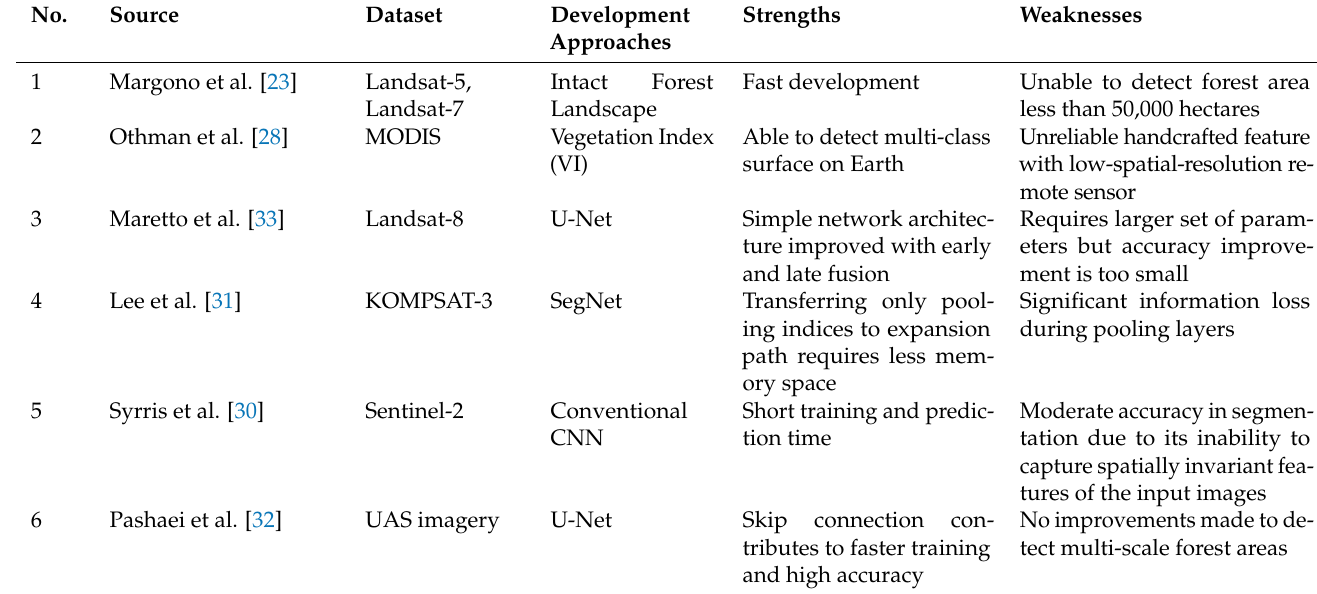
Table 2. Summary on automatic forest monitoring